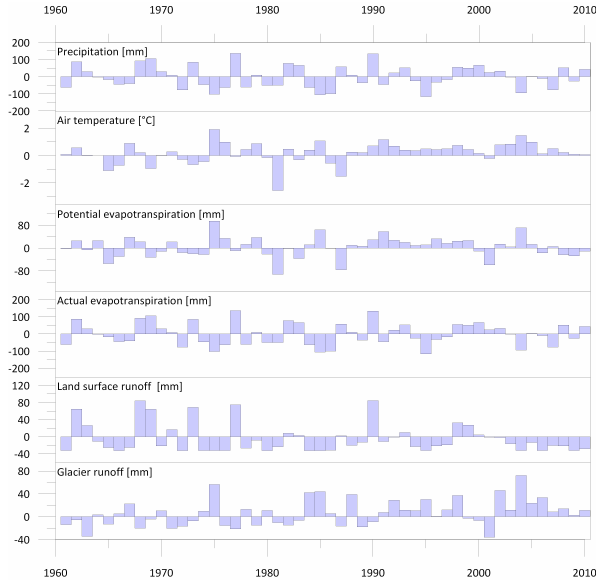
Fig. 3. Mean basin wide annual anomalies (from 1960–1990 mean) of various climate and water balance terms.